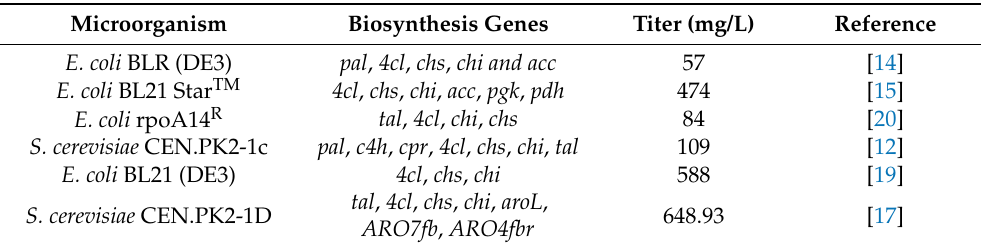
Table 1. Heterologous production of (2 S )-naringenin in Escherichia coli and Saccharomyces cerevisiae